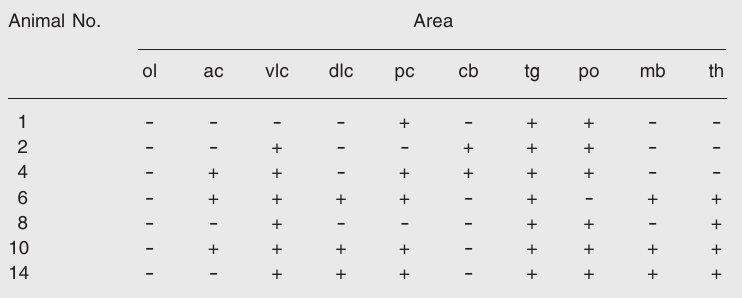
Table 3. Detection of bovine herpesvirus 5 DNA by PCR in brain sections of rabbits 60 days after dexamethasone-induced virus reactivation (group B). Animal